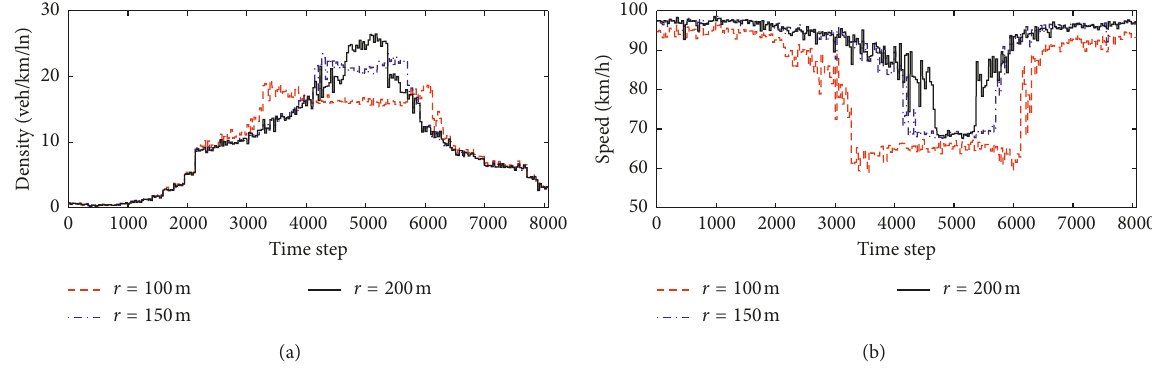
Figure 5: (a) Mainstream density and (b) mainstream speed under different foggy weather model correction factors is 6.22%. Clearly, the traffic model indicated in Figure 7, two model correction factors c m 1 and with one model correction factor achieves a better perfor- c m 2 are applied to the mainstream traffic density and speed, mance than that with two factors. respectively. The fitness value of the traffic model with two